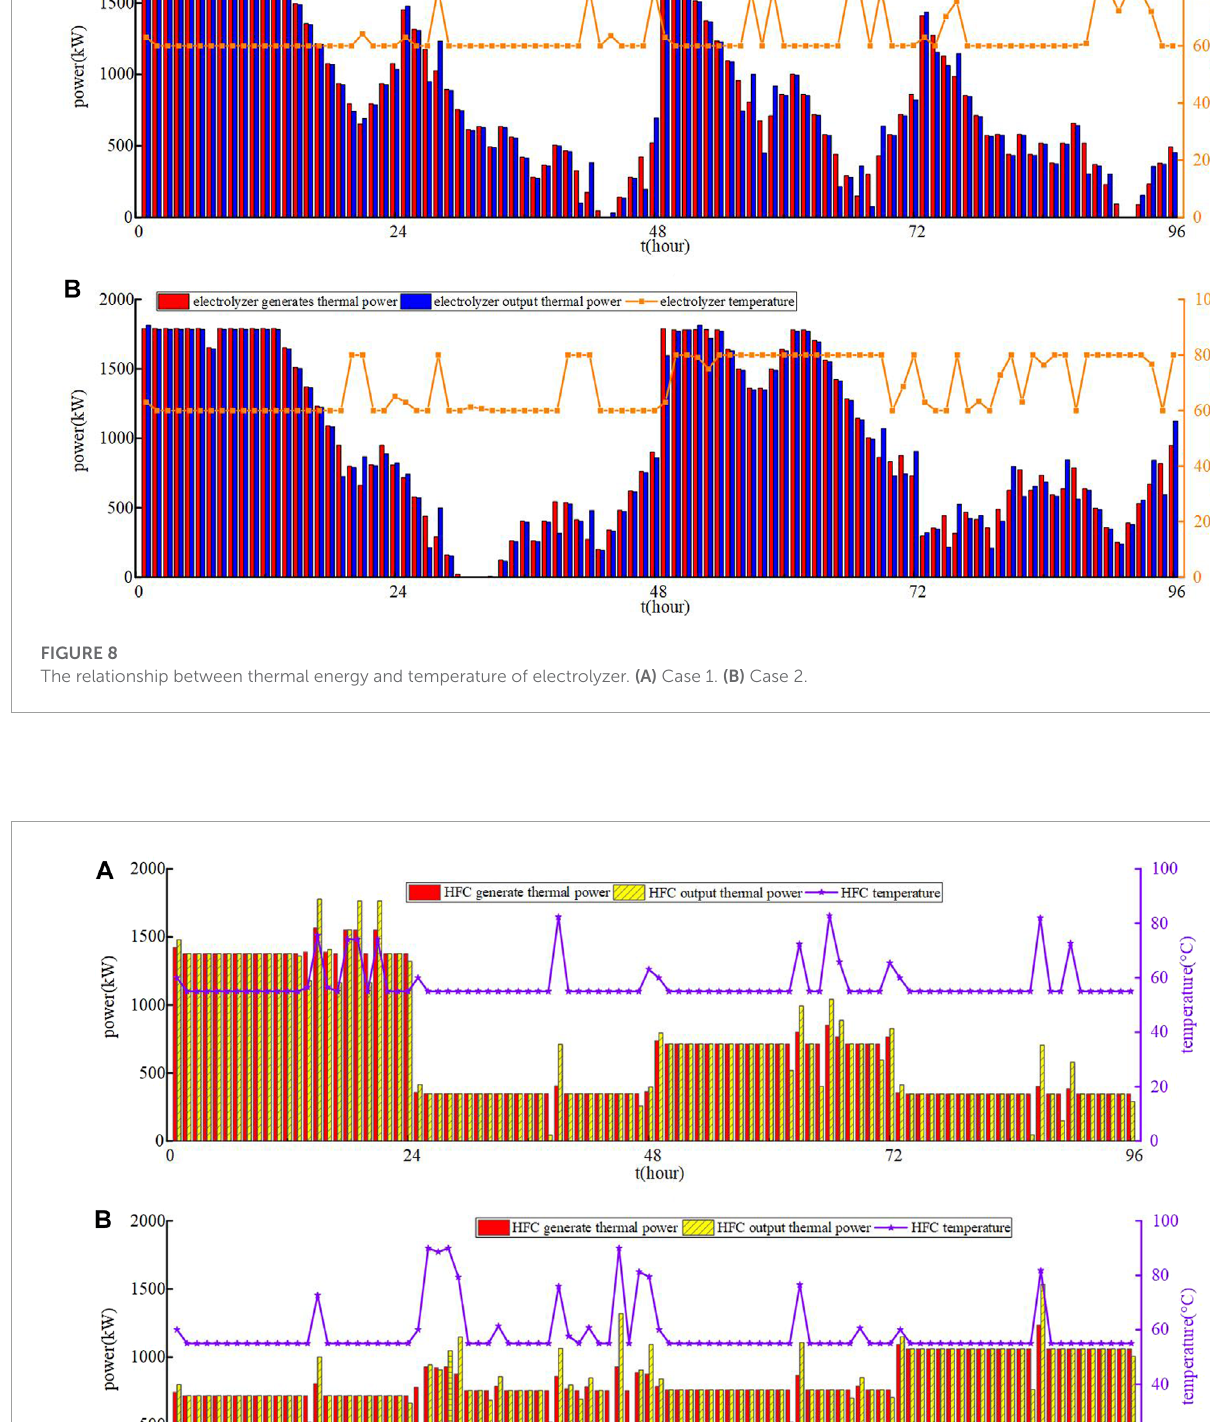
Frontiers in Energy